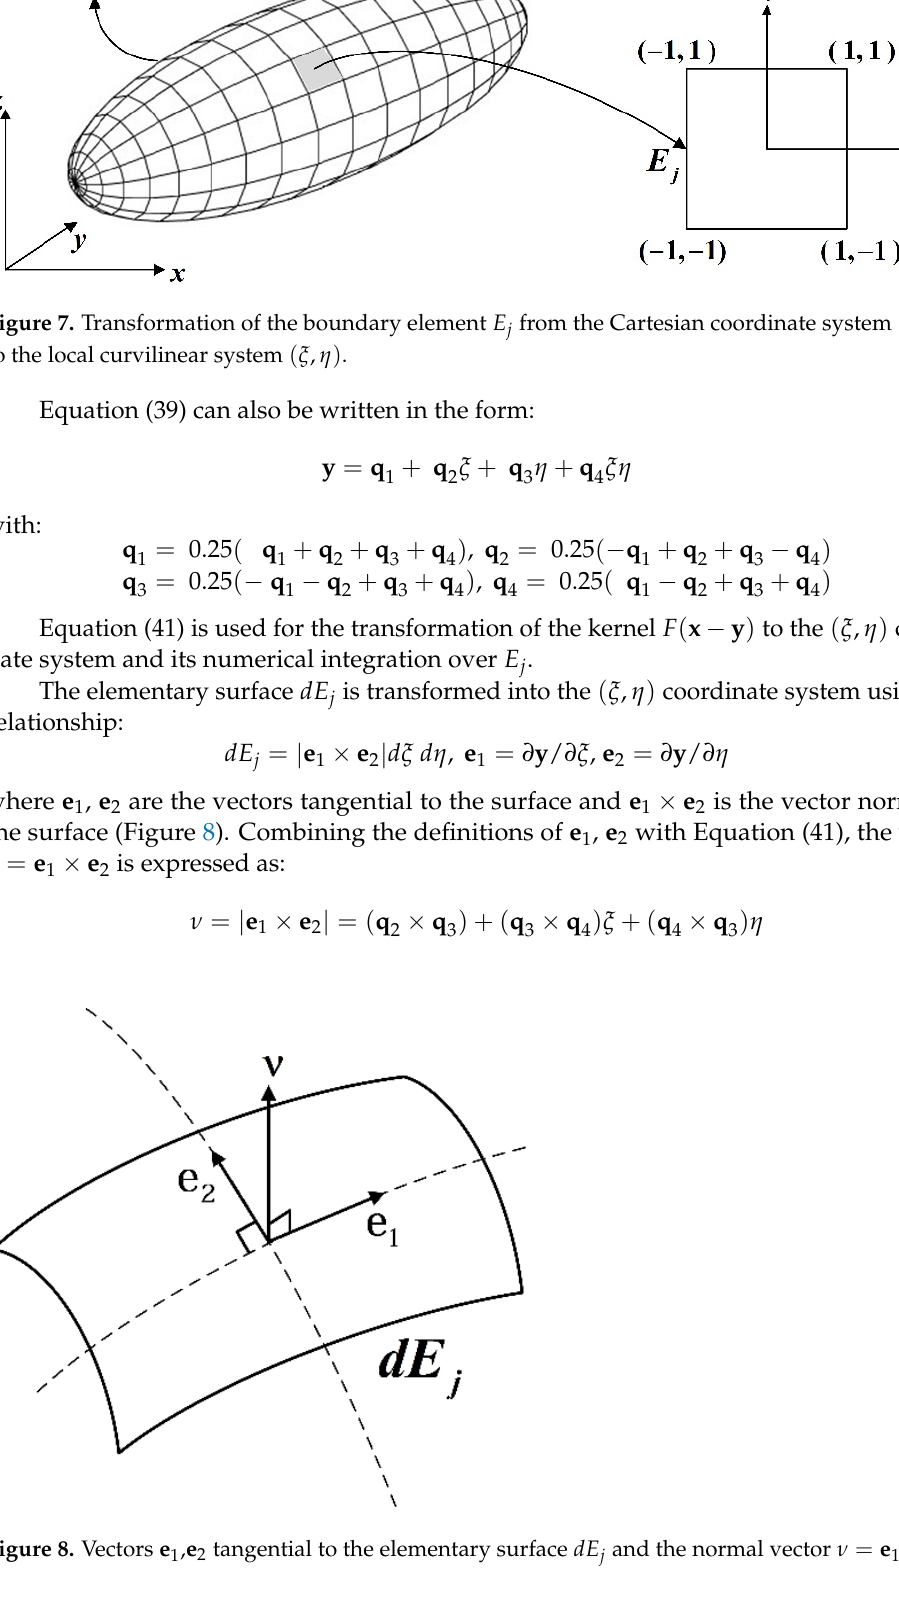
e , e tangential to the elementary surface dE 1 2